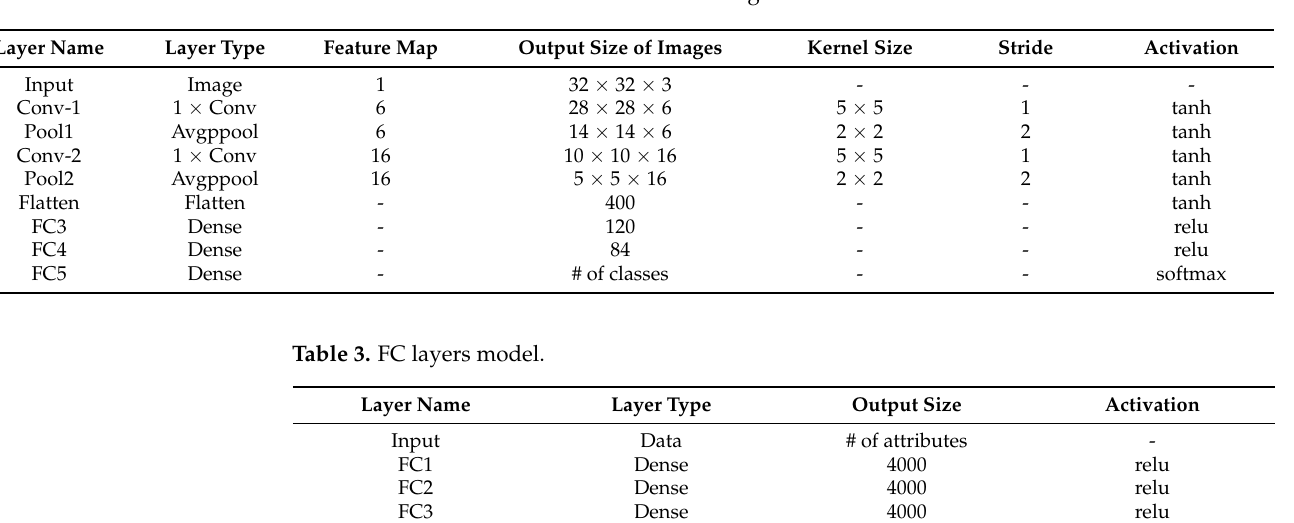
Table 2. Lenet5 model trained for 32 × 32 images.